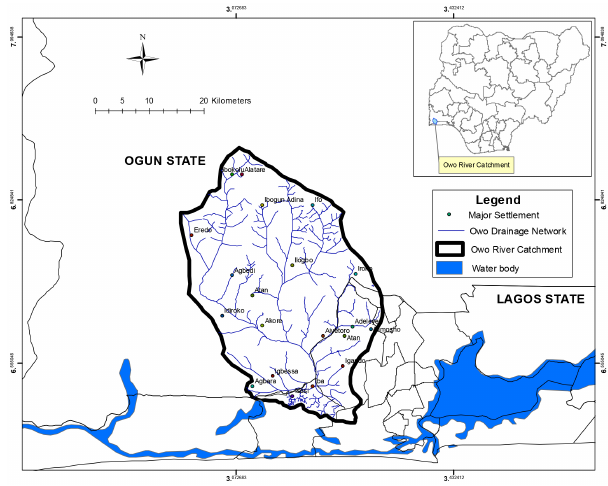
Figure 1. Owo River